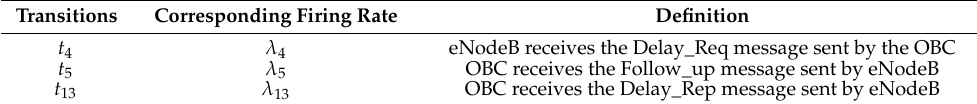
Table 3. Definition of vulnerable nodes.